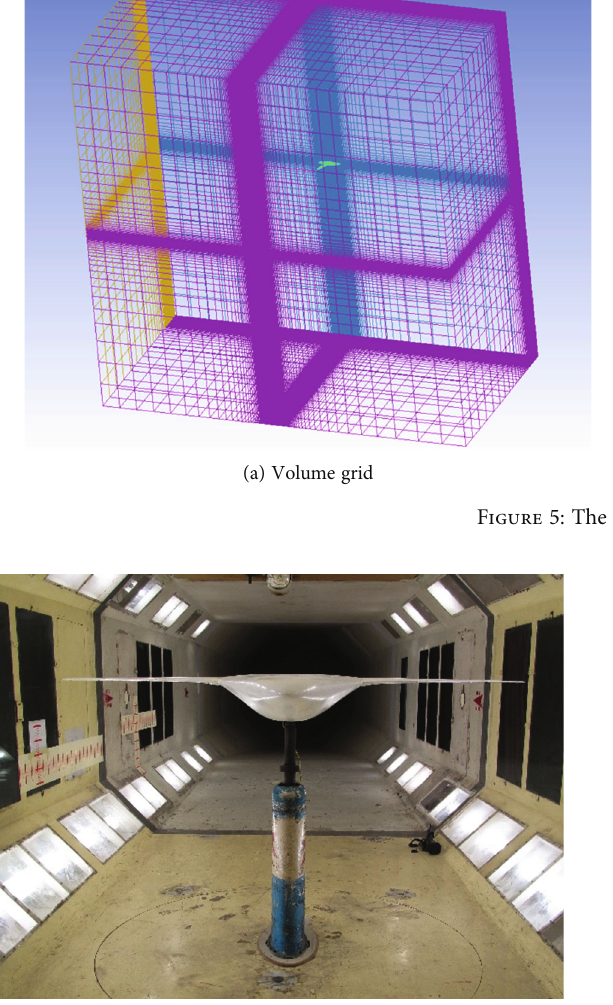
Figure 6: SWB wind tunnel